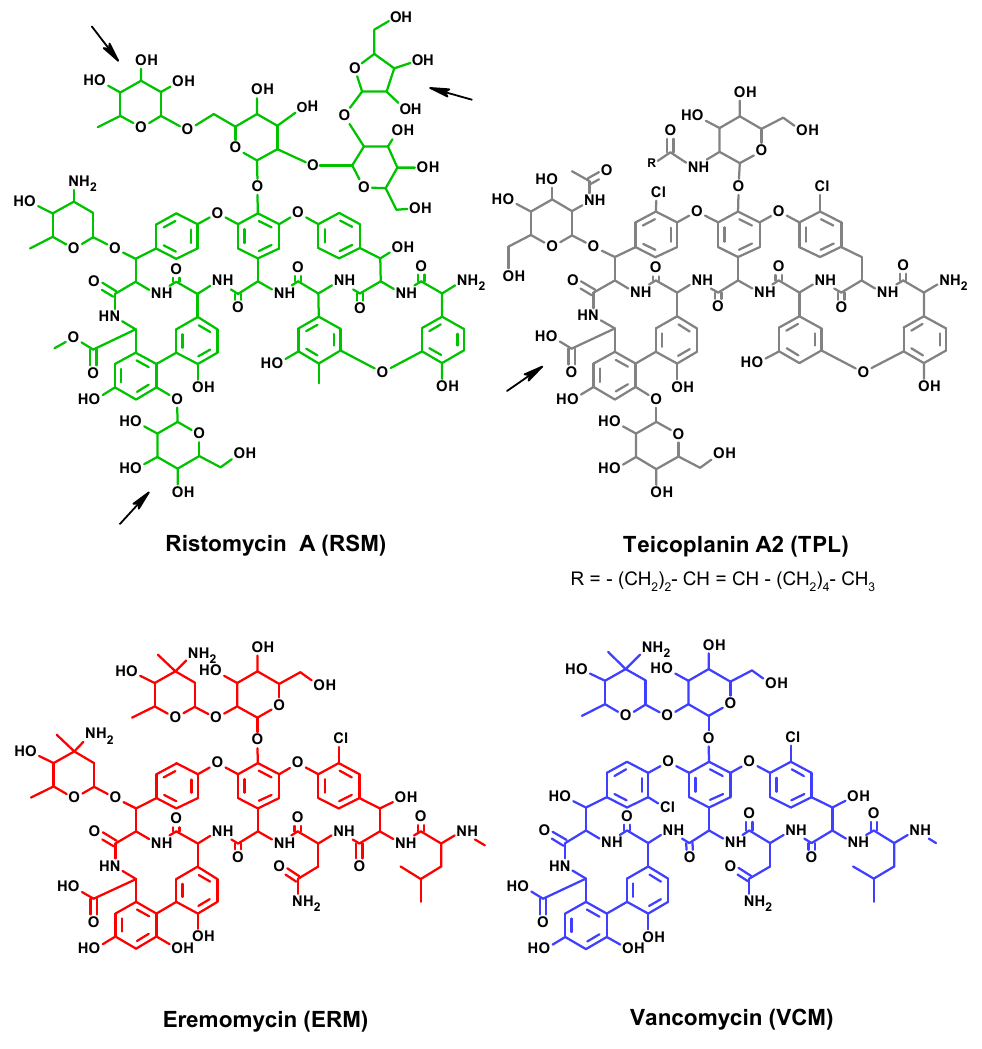
Figure 1. Structures of glycopeptide antibiotics. The sites of possible coupling between glycopeptides and carriers in immunogens are indicated by arrows.